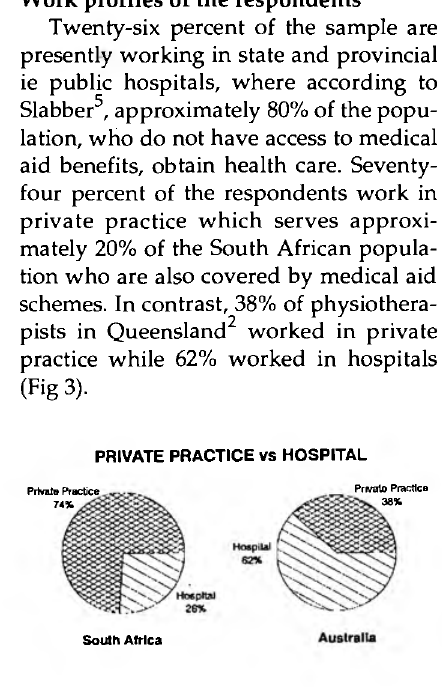
Fig 4: Changes in hospitals vs private practice